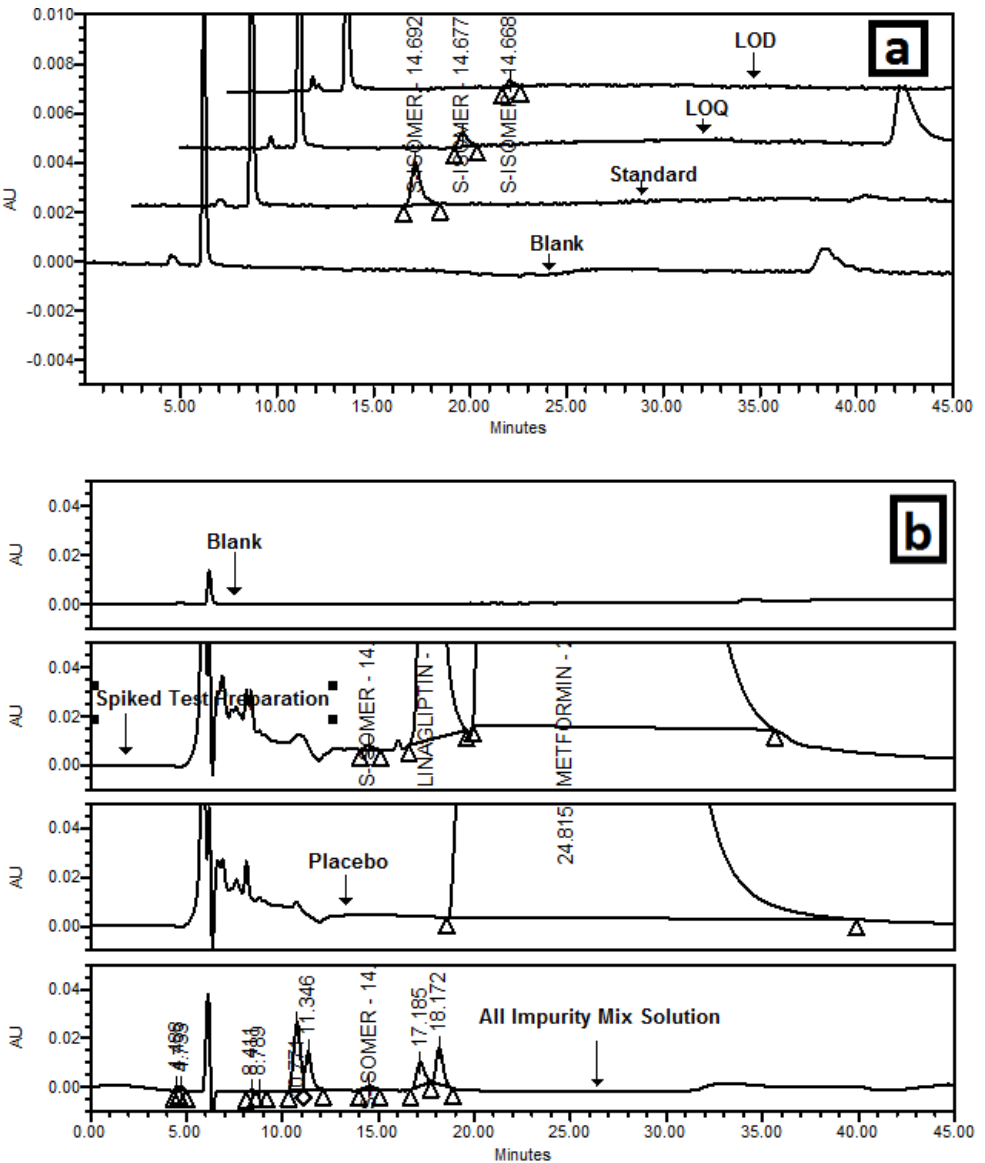
Figure 6. ( a ) Overlaid chromatogram of blank, standard, limit of detection (LOD) and limit of quantitation (LOQ); ( b ) Overlaid chromatogram of a blank, S -isomer spiked test preparation, placebo/matrix, LGP and MET HCl impurity mix solution.